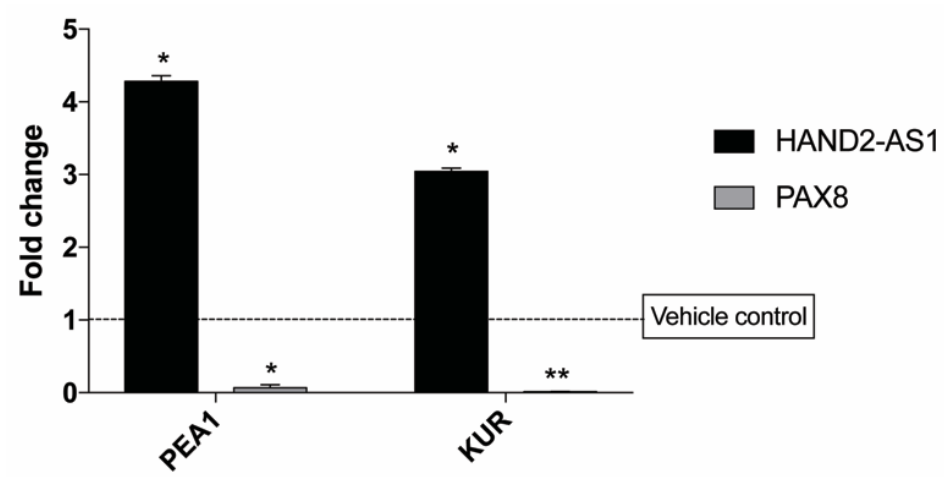
Figure 4. Expression of HAND2-AS1 and PAX8 in PEA1 and KURAMOCHI cells upon 48 h of treatment with the HDAC inhibitor Panobinostat and the corresponding vehicle control. Values from experiments (n = 2) are expressed as means ± SD from real-time PCR performed in duplicates normalized using the house-keeping gene Abelson (ABL) expression. p -value was calculated between control and test groups using Student’s t-test (two-tailed) with the cutoff as p ≤ 0.05 wherein asterisks denote significance. * p < 0.05, ** p < 0.01.